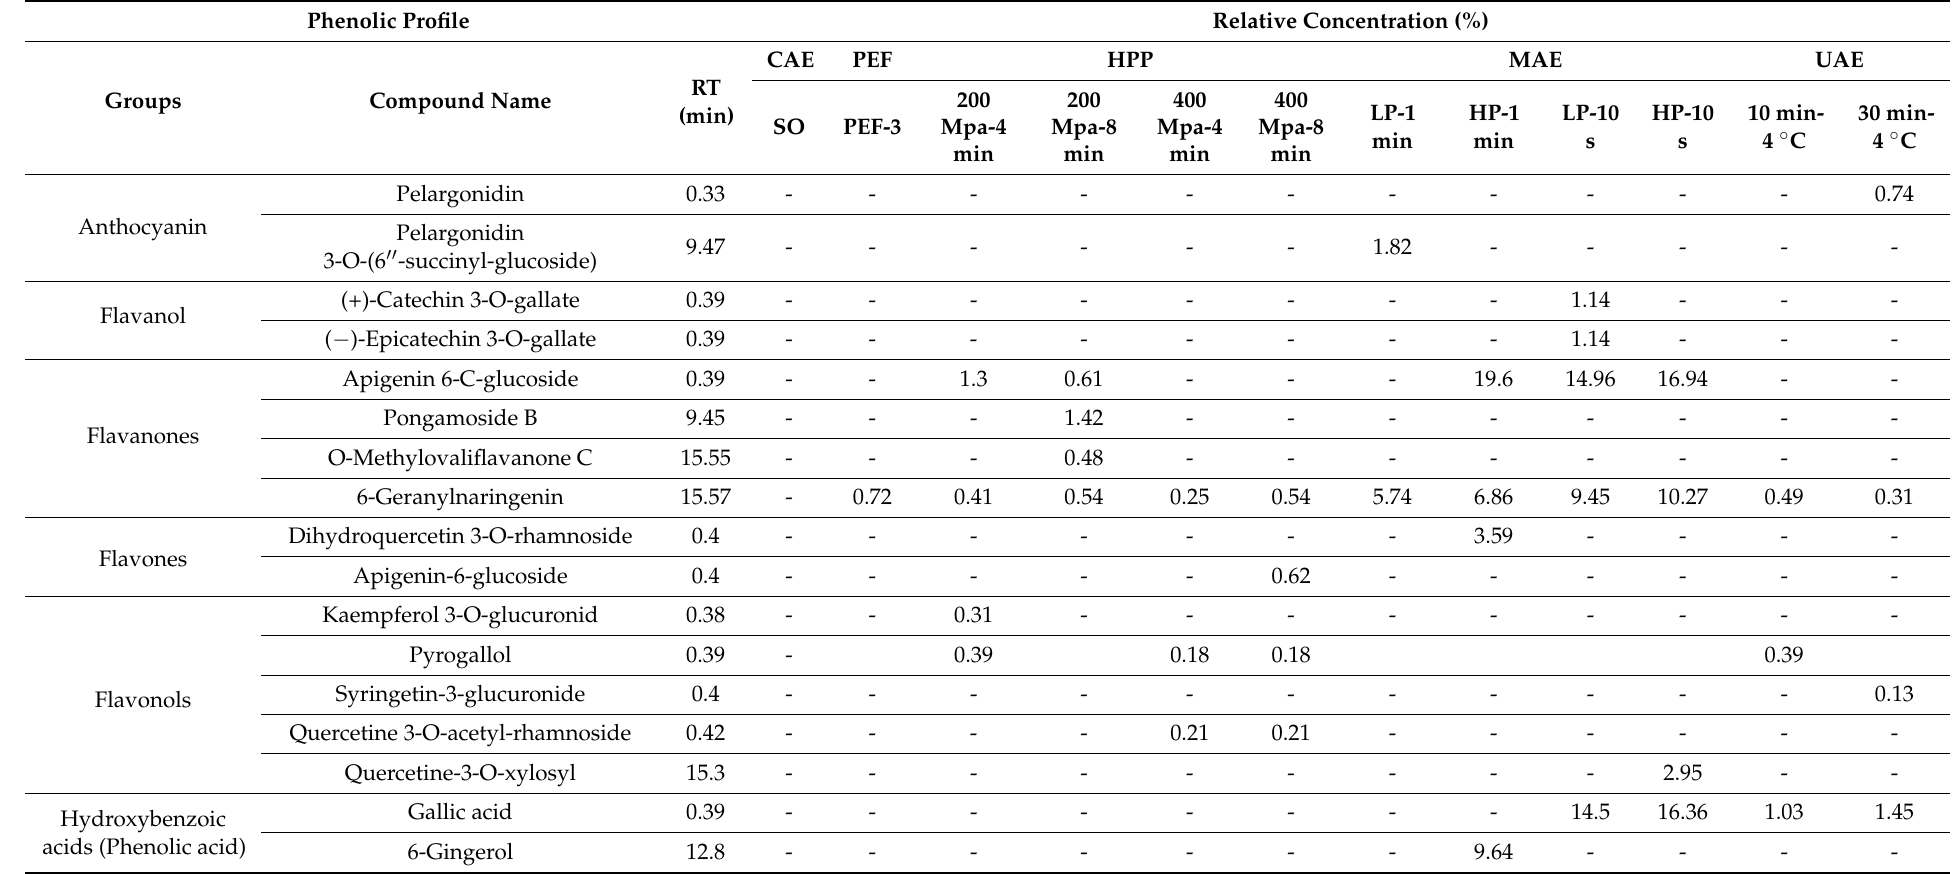
Table 2. A summary of the phenolic compounds and their relative concentrations estimated in buckwheat hull extracts using CAE, PEF, HPP, MAE, and UAE extraction